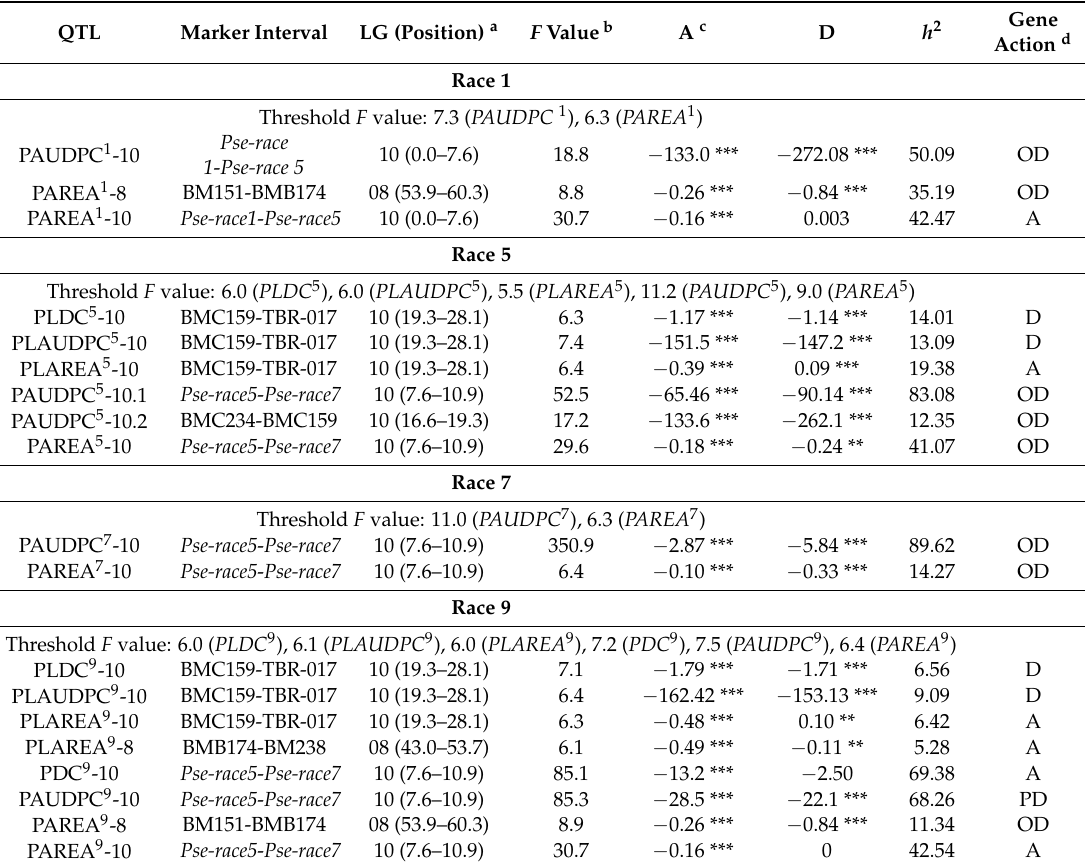
Table 5. Single-locus effect QTLs detected for primary leaf and pod resistance to races 1, 5, 7 and 9 in the UI3T F 2